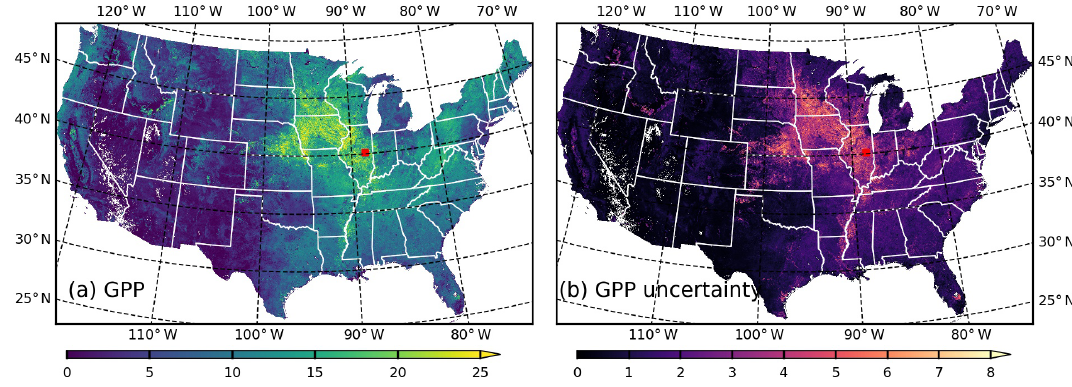
Figure 12. Spatial distribution of 250m resolution (a) GPP (gCm − 2 d − 1 ) and (b) GPP uncertainty (gCm − 2 d − 1 ) across the CONUS on 10 July